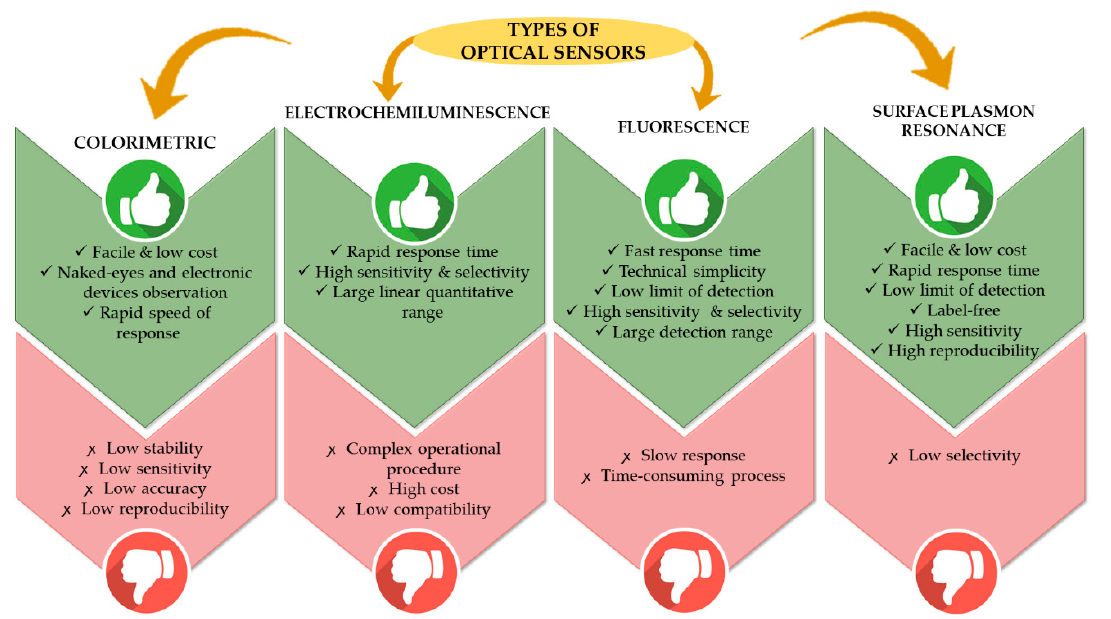
Figure 1. Comparison of advantages and disadvantages of optical sensors for heavy metal ion detection.